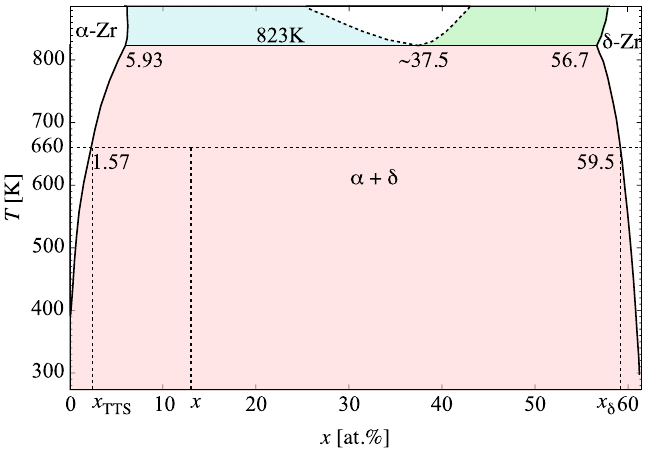
Figure 4. Phase diagram of the Zr-H system in the temperature and concentration region relevant to the present study (adapted from several sources